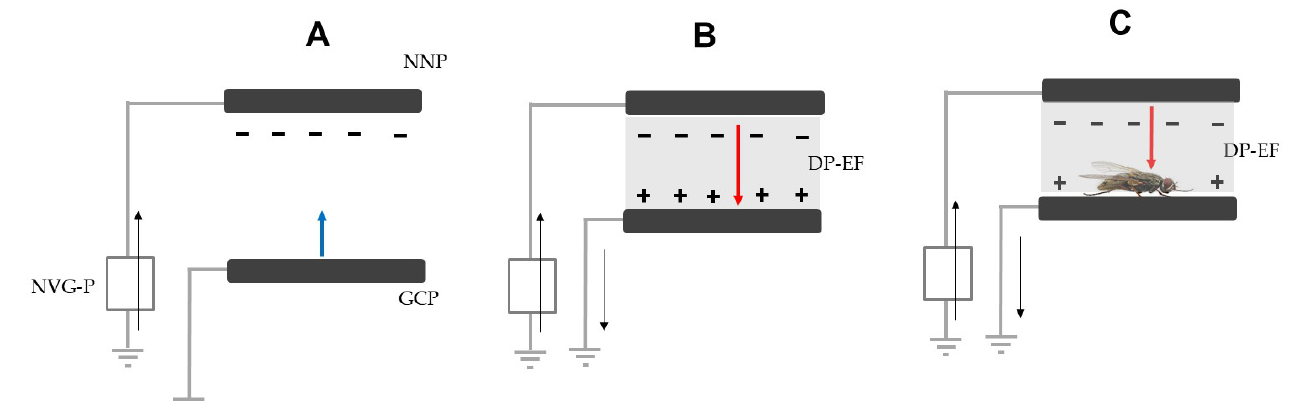
Figure 2. ( A , B ) Schematic representation of arc-discharge generation by an experimental instrument. The instrument consisted of a negatively charged non-insulated conductor plate (NNP) linked to a negative voltage generator (pulse-charge type) (NVG-P), and a grounded conductor plate (GCP). The GCP was lifted gradually (blue arrow) ( A ) and settled in a position that caused an arcing (red arrow) by the NNP ( B ), where a dipolar electric field (DP-EF) was formed between the two plates to positively polarize the GCP. In this position, the pulsed arcing continuously occurs at an interval of 1 s. The arcing was preferentially directed to an insect that was located on the GCP ( C